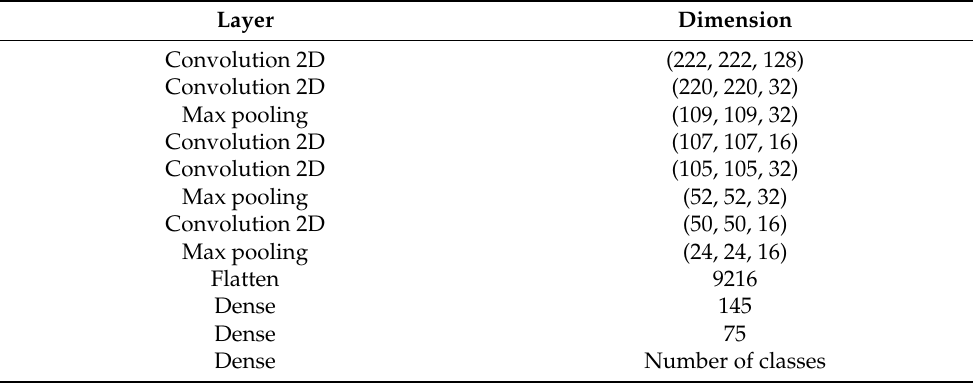
Table 5. Architecture of the convolutional neural network (CNN) used for classification.